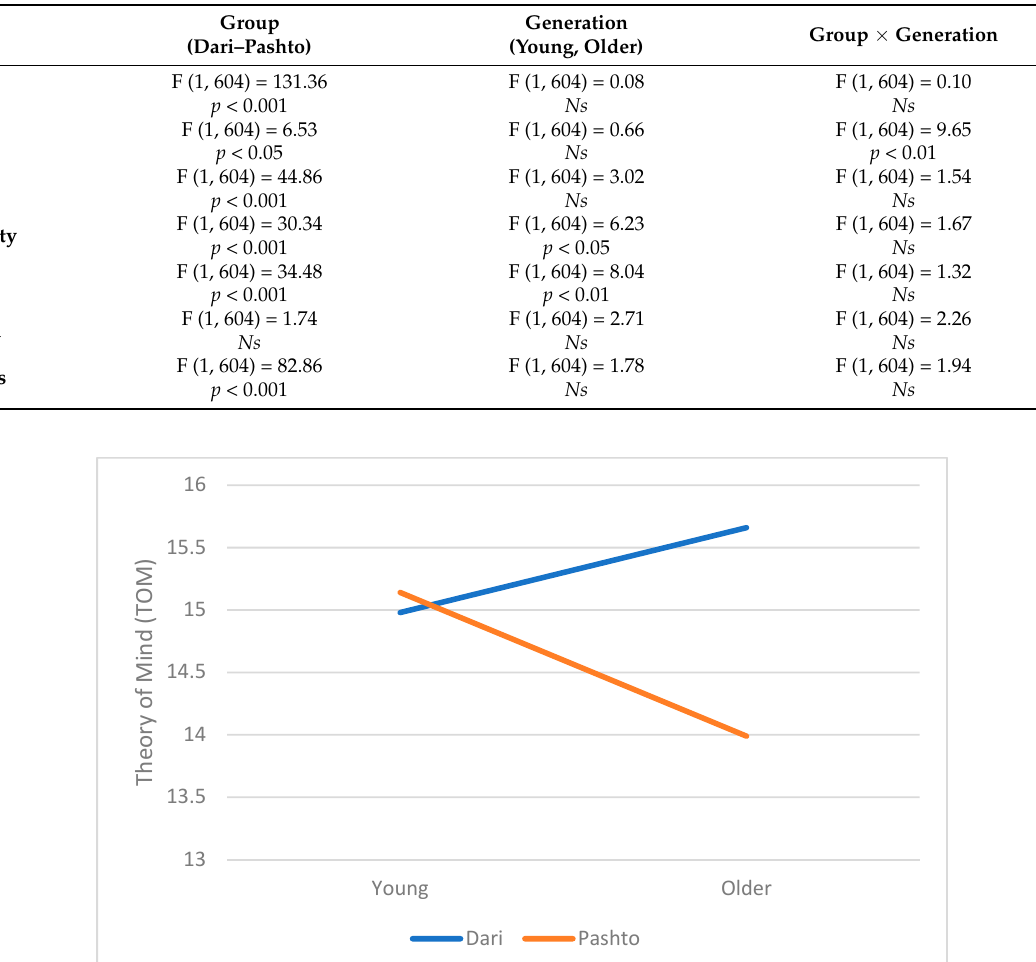
Table 2. MANOVA results on target variables for group and generation factors and their interaction.